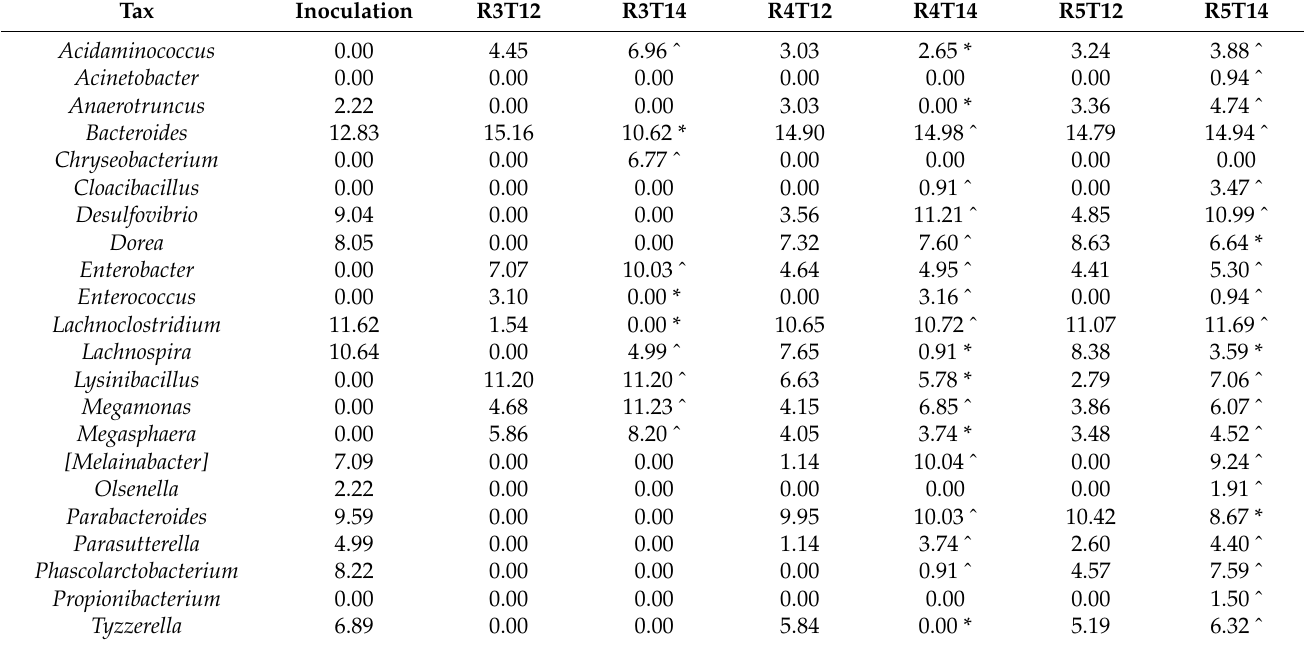
Table 4. Bacterial genus abundance in the three colonic sections. R3T12 represents the end of the stabilization period and R3T14 the end of the treatment period. Values show relative abundance %.